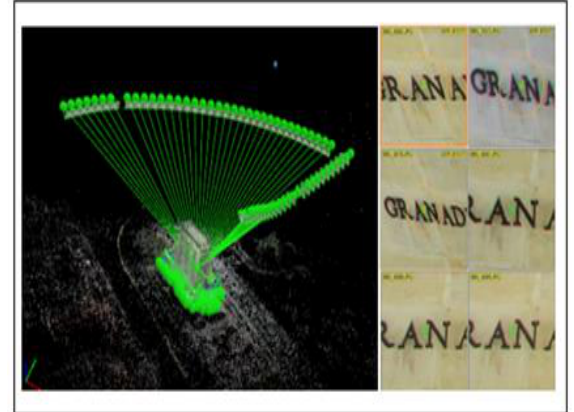
Figure 11: Displaying the same point between your different images in which the pixel appears.